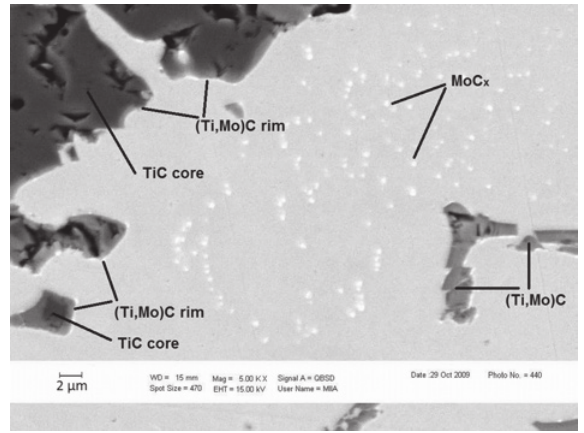
Fig. 12: SEM-BSE image of TiC and (Ti,Mo)C particles in experiment 2 (FeMo5.2-TiC A) [22]